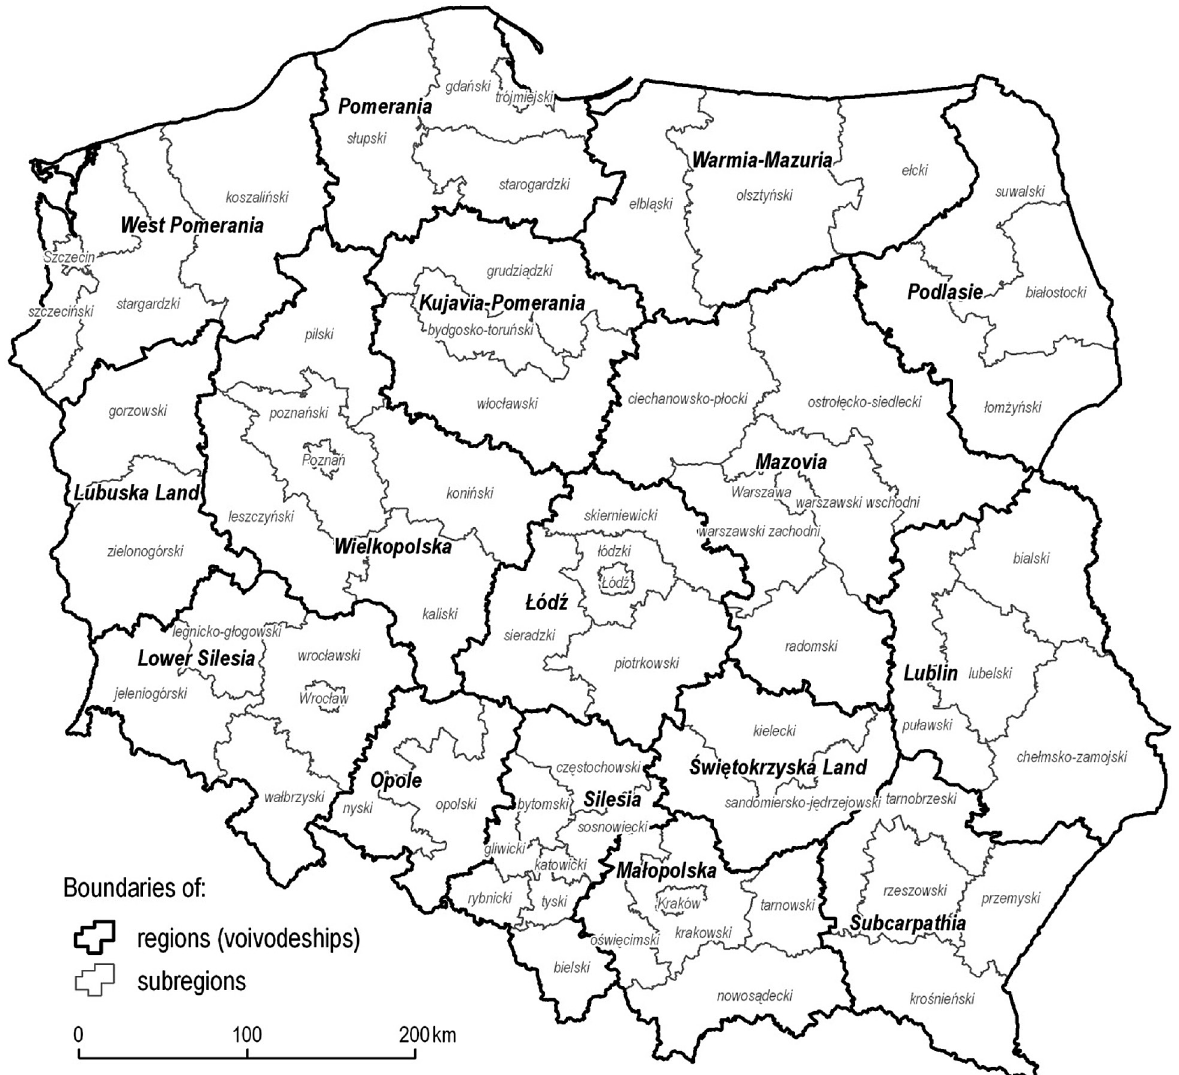
Fig. 1. Poland’s division into regions and